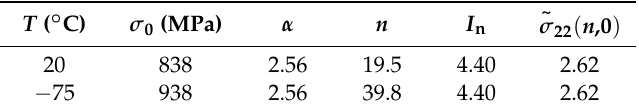
Table 2. Ramberg–Osgood parameters ( σ 0 , α , and n ) and related Hutchinson–Rice–Rosengren (HRR) stress-distribution parameters ( I n and (cid:101) σ 22 ( n ,0 ) ) for HT780. Note that the values of I n and (cid:101) σ 22 ( n ,0 ) for